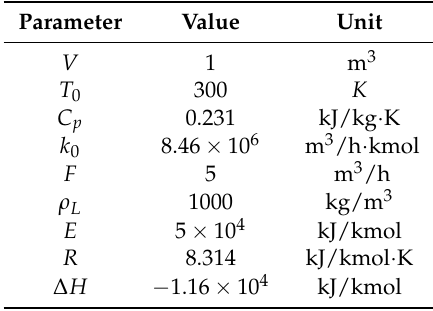
Table 4. CSTR model process